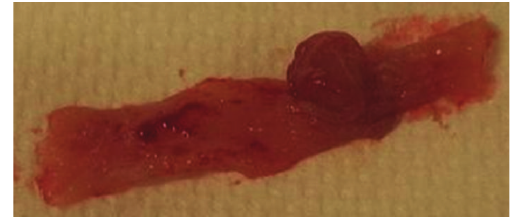
Figure 7: Ulceration, thickening of the mucosal wall, and a polyp in distal colon from a rat in the DSS group.